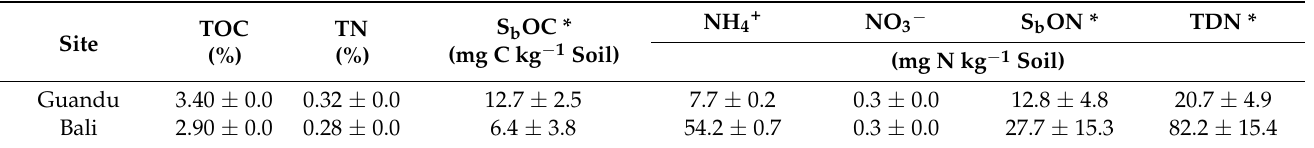
Table 2. Concentrations of soil total organic carbon (TOC), total nitrogen (TN), and soil soluble organic C and N in 2 M KCl extracts from the Guandu and Bali mangrove